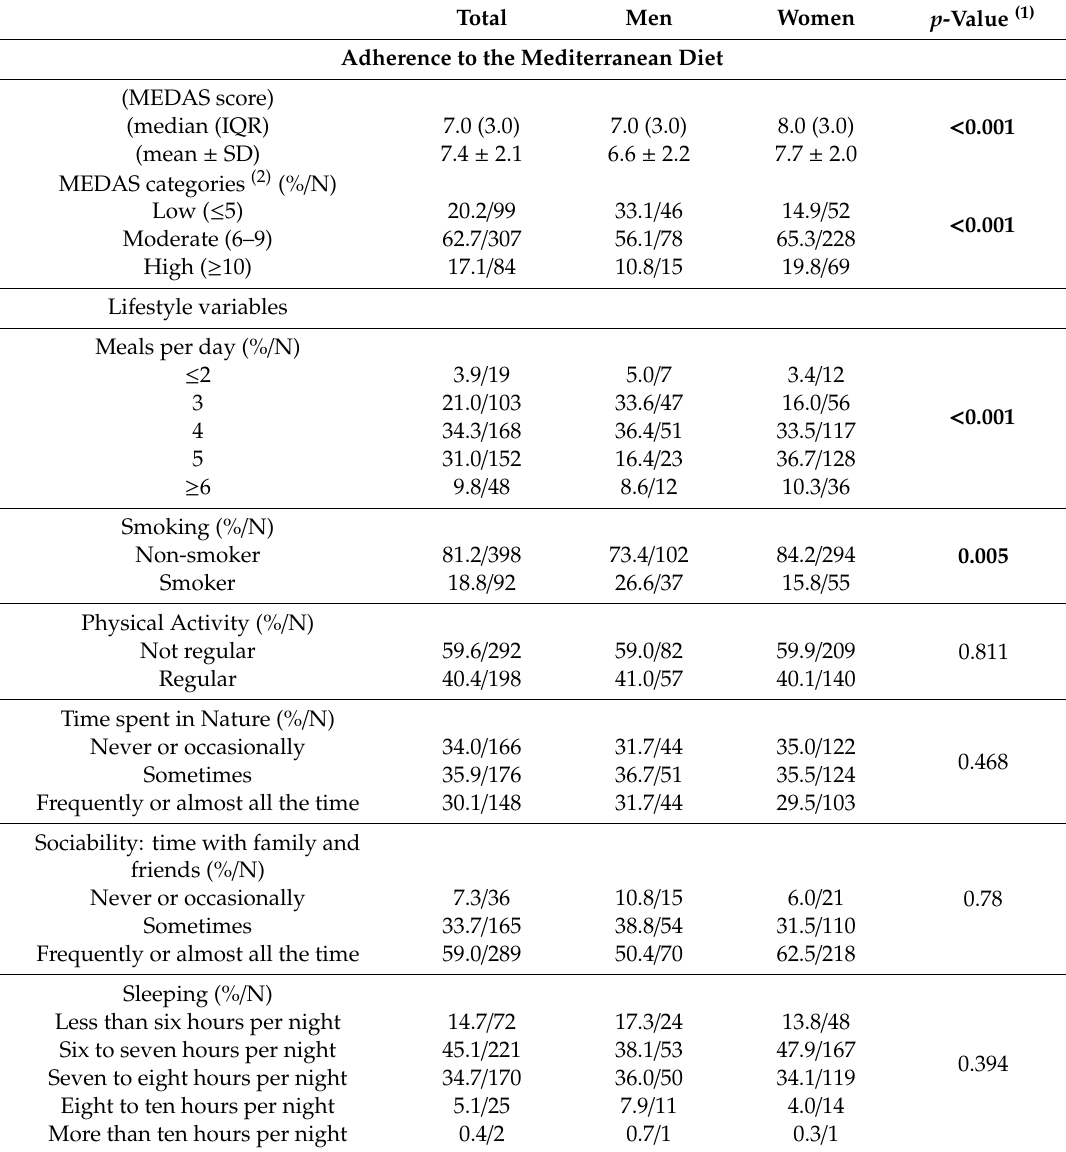
Table 2. Participants’ MD adherence, other lifestyle variables, and gender